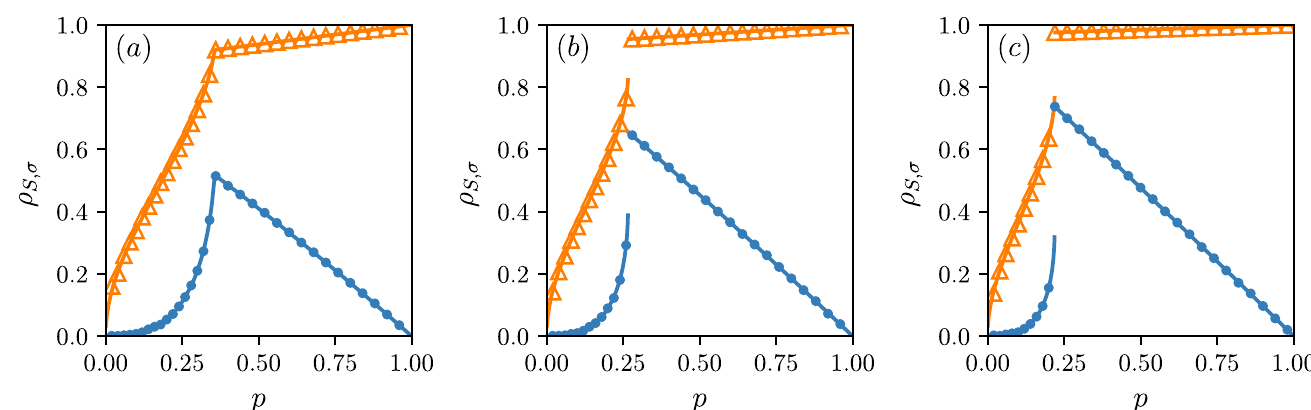
Fig 3. Pearson correlation coefficient between public and private opinions. Results for different q -panel sizes are presented: (a) q = 4, (b) q = 5 and (c) q = 6. Analytical results are marked by lines. Symbols illustrate outcomes from Monte Carlo simulations: 4 for the TA (think then act) and • for the AT (act then think) models. The system starts its evolution from the ordered state for all cases. We can see that the states of opinions on public and private levels are more strongly correlated in the TA model. On the other hand, for small values of the independence level, the correlation coefficient stays close to zero in a wider range of independence variability for the AT model. Note that in the high-independence phase, our measure of association increases to 1 for the TA model whereas it decreases to 0 in the case of the AT model. Results from Monte Carlo simulations have been obtained for the system of the size N = 10 6 after 10 3 MCS.